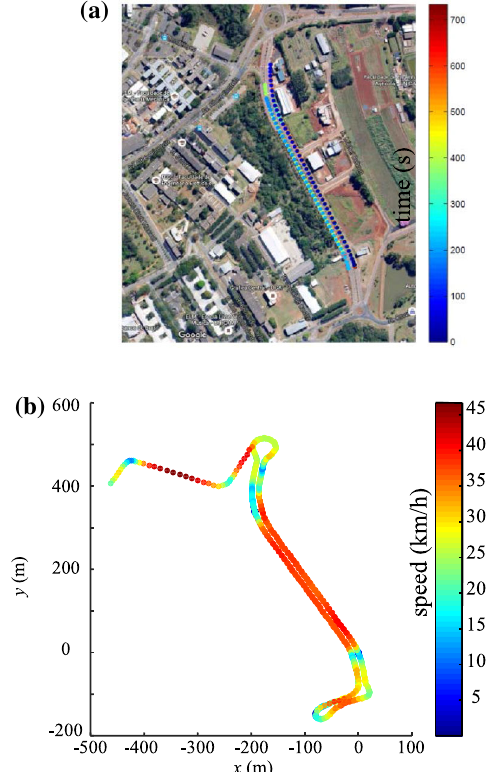
Fig. 8 Route used in the experimental test. a Route used to test cooperative control. The color means the time (s) when the point was reached. b Speed of the vehicle in km/h (color) in the test